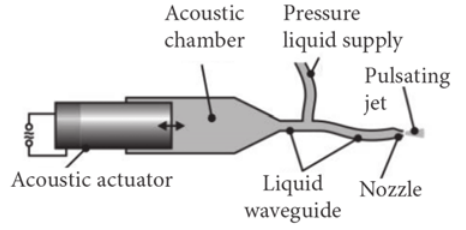
Fig. 2. Schematic drawing of the high-pressure system with integrated acoustic generator of pressure